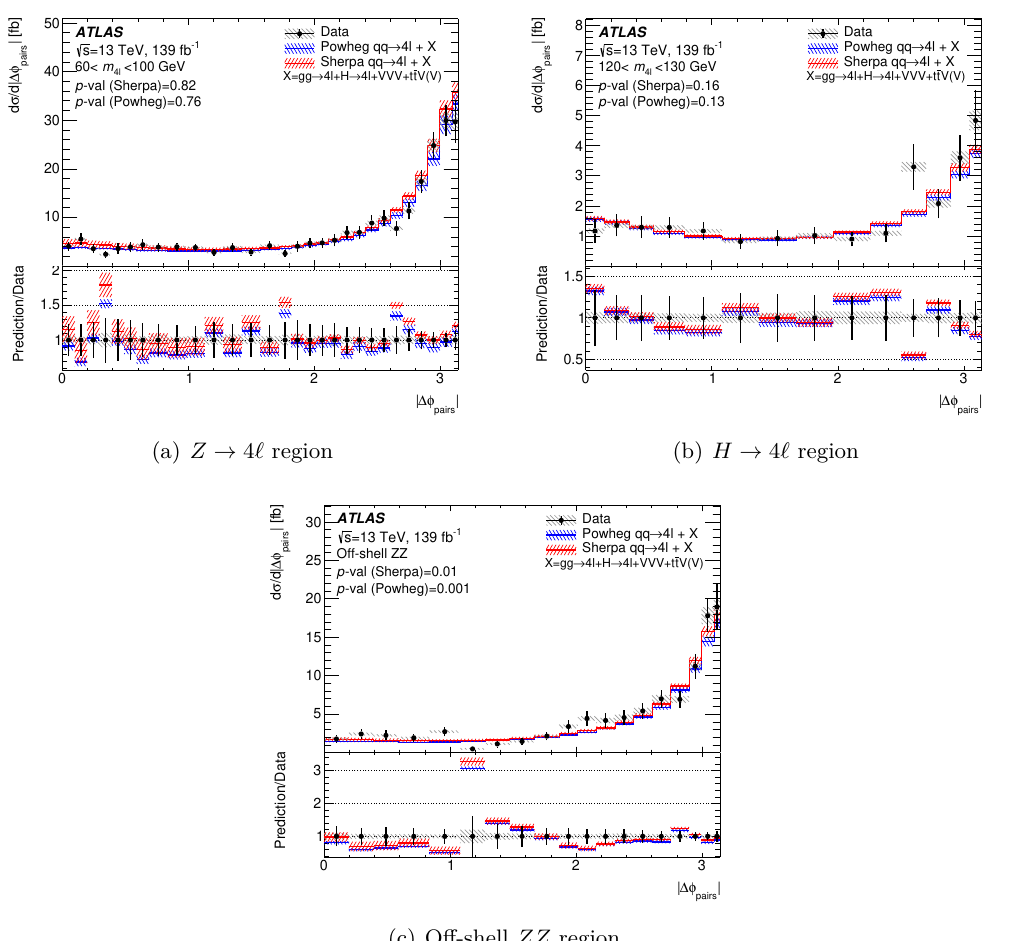
Figure 19 . Differential cross-section as a function of | ∆ φ pairs | in m 4 ‘ regions. The measured data (black points) are compared with the SM prediction using either Sherpa (red, with red hashed band for the uncertainty) or Powheg + Pythia8 (blue, with blue hashed band for the uncertainty) to model the q ¯ q → 4 ‘ contribution. The error bars on the data points give the total uncertainty and the grey hashed band gives the systematic uncertainty. The p -value is the probability for the χ 2 , with the number of degrees of freedom equal to the number of bins in the distribution, to have at least the observed value, given the SM prediction. The lower panel shows the ratio of the SM predictions to the